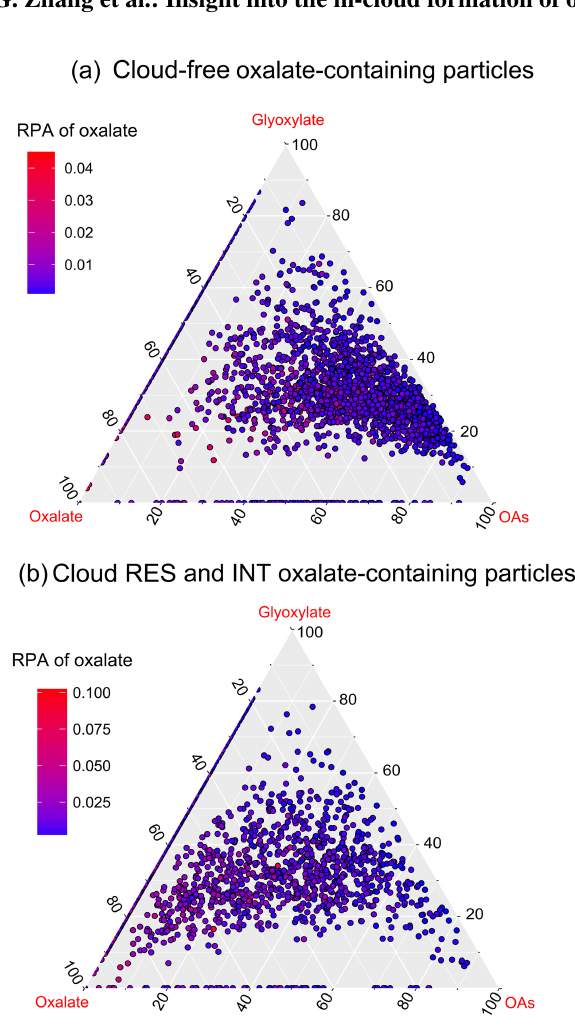
Figure 6. The relative distributions of the peak areas of oxalate, glyoxylate, and the OAs for (a) the individual cloud-free and (b) the cloud RES and cloud INT oxalate-containing particles. The peak areas of the OAs were summed from those of the individual OAs. The coloration indicates the RPA of oxalate.